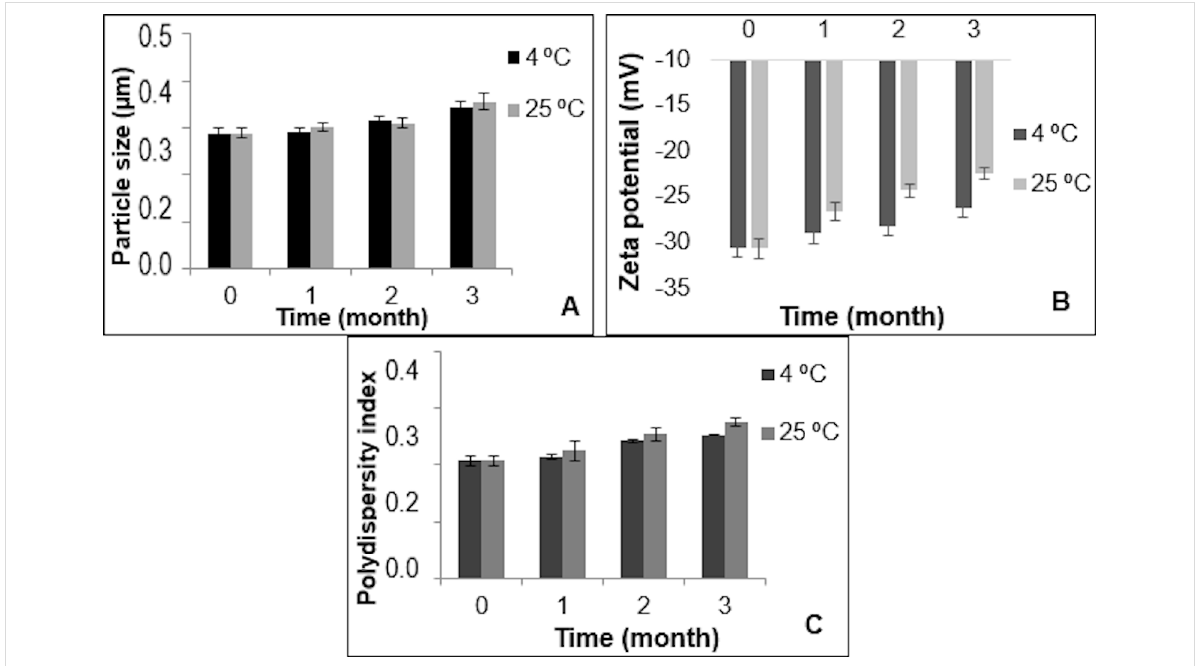
Figure 3: The changes in the PS, ZP, and PDI of the: (A, B and C) suspended ETHs at 4 and 25 °C. (Values are expressed as mean ± standard de- viation, n = 3).